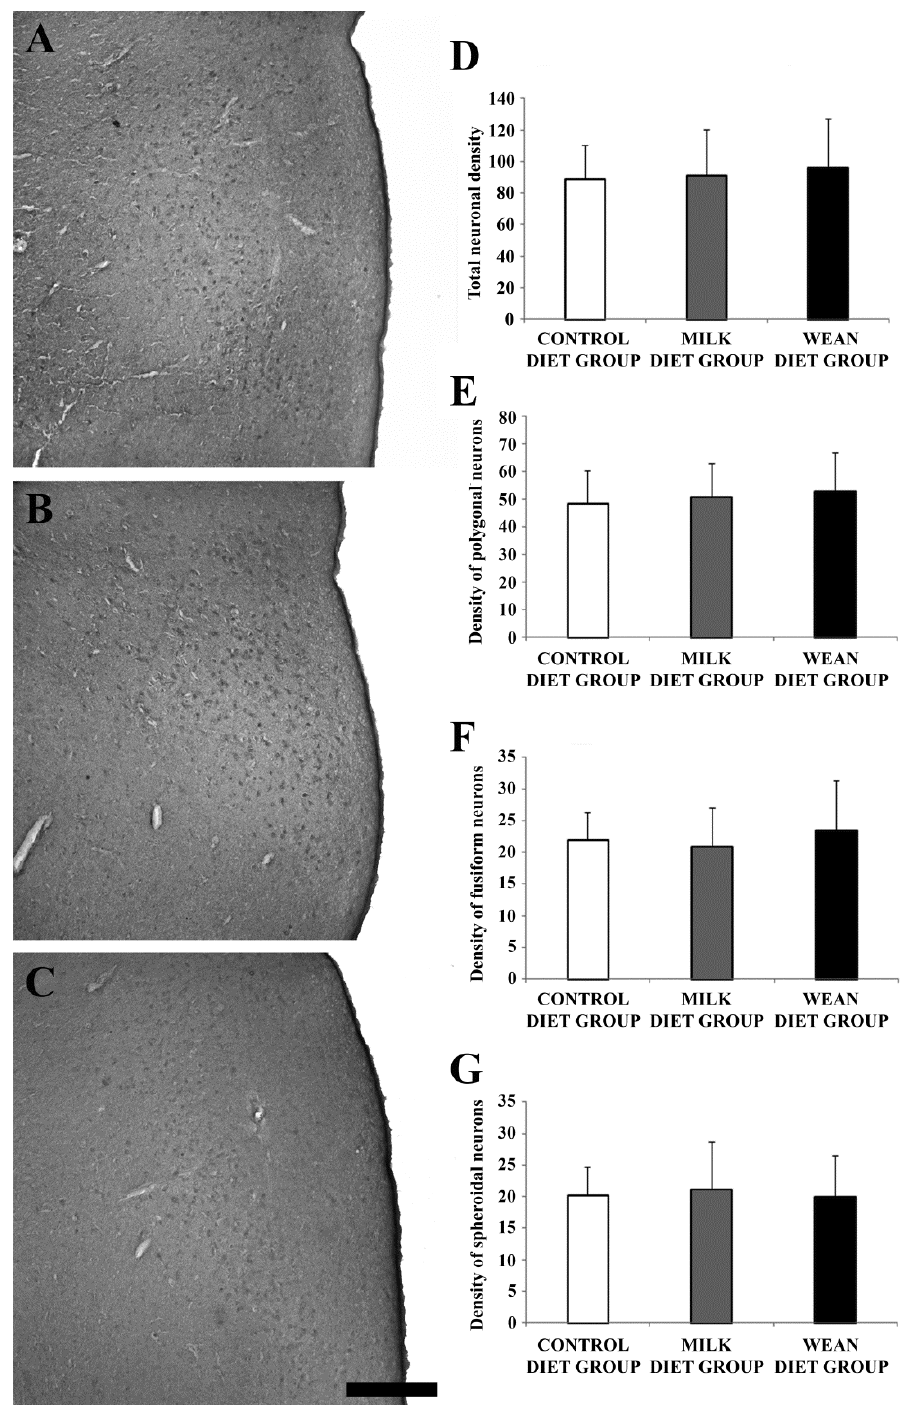
Figure 2. Brightfield photomicrographs of coronal sections ( A – C ) and histograms ( D – G ) showing the distribution of oxytocin immunoreactivity in the paraventricular nucleus of the control diet group ( A ), milk diet group ( B ), and wean diet group ( C ). The density (number of somata / mm 2 ) of oxytocin-immunoreactive (IR) neurons does not vary significantly in the different groups ( D – G ). Note that the intensity of immunostaining is lower in wean diet group than in the control and milk diet groups (see also table 1). Scale bar = 500 µm in C (applies to A – C).